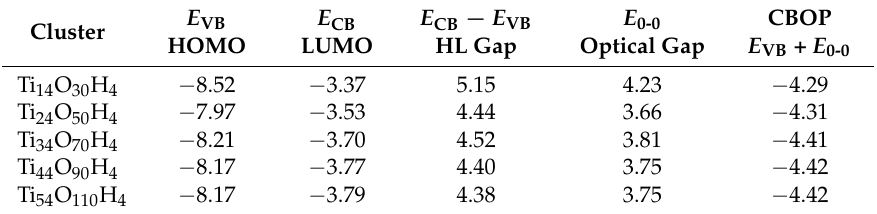
Table 3. Valence ( E VB ) and conduction ( E CB ) band edges, the band gap ( E CB − E VB ), the optical gap, and the conduction band oxidation potentials (CBOP) (in eV), calculated for clusters of various sizes, using DFT and Time-Dependent DFT (TD-DFT), the B3LYP functional, LANL2DZ basis sets, and water solvent. E VB E CB E CB − E VB Cluster HOMO LUMO